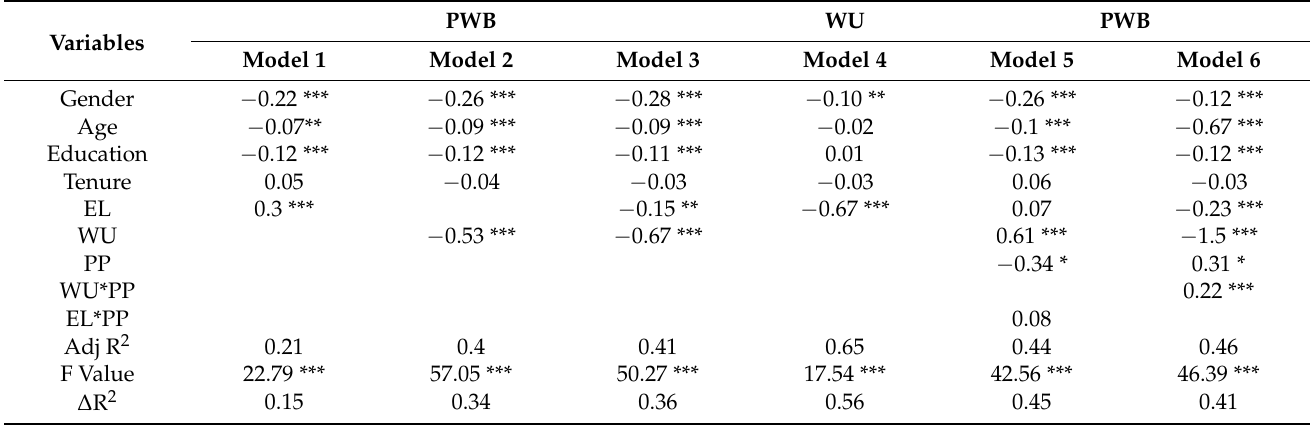
Table 3. Hierarchical regression